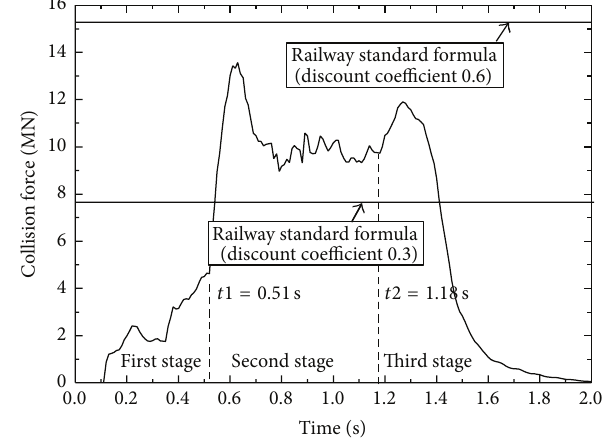
Figure 7: Deformation of the whole bridge under collision (ampli- fied 100 times). displacement curves of the bridge girder at different locations (points A, B, C, D, and E) are also shown in Figure 10. And the lateral displacement field of the whole bridge in the down direction is described in Figure